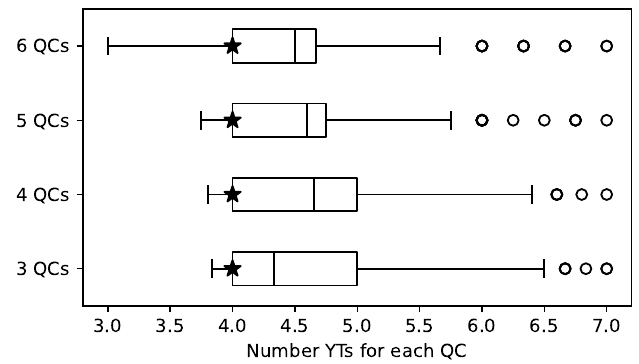
Figure 10. The number of YTs in the set of approximated optima. The parameter value that leads to the best objective function value over all optimization runs is marked with an